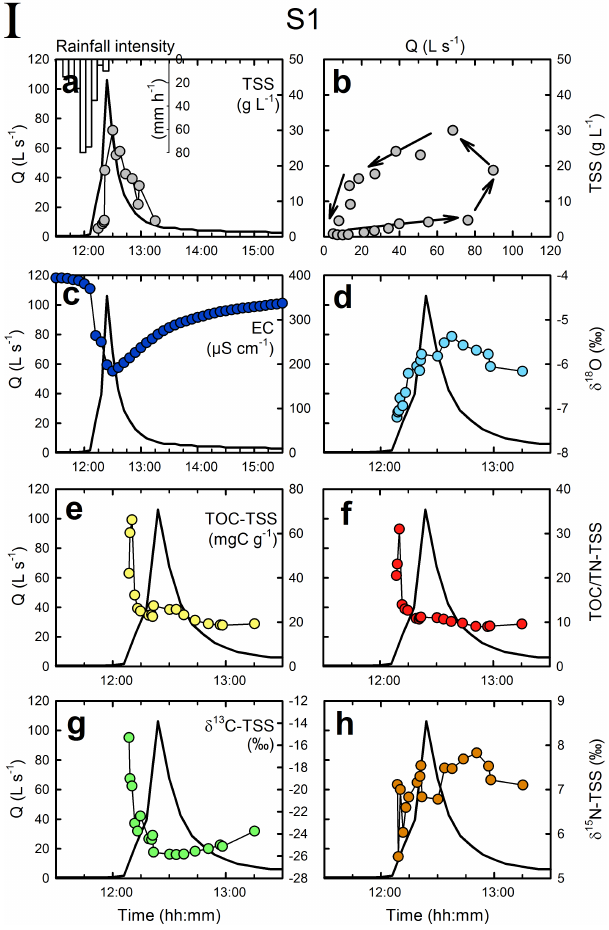
Figure 3. Plots of the temporal evolution of (a) rainfall intensity, stream discharge ( Q , thicker solid line), (b) total suspended sedi- ment load (TSS), (c) water electric conductivity (EC), (d) stream water- δ 18 O, (e) total organic carbon concentration in the TSS (TOC-TSS), (f) total organic carbon:total nitrogen ratio in the TSS (TOC / TN-TSS), (g) δ 13 C-TSS, (h) δ 15 N-TSS for: (I) the upstream station S1, (II) the intermediate station S4, and (III) the downstream station S10, during the 23 May 2012 flood. Horizontal bars repre- sent sampling period for composite